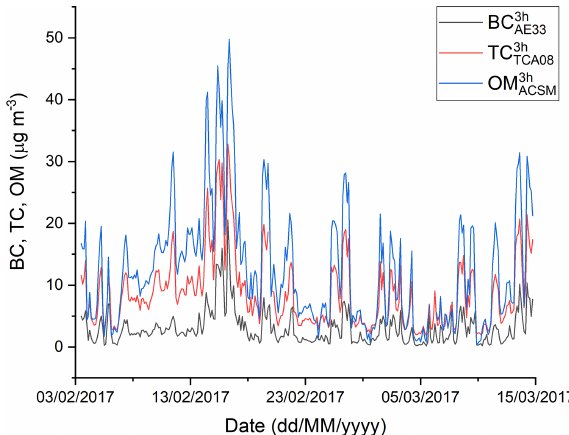
Figure 10. Time series comparisons of high-time-resolution online measurements of OM by ACSM on 29–30min time base, BC by AE33 on 1min time base and TC by TCA08 on 1h time base. All data are averaged to 3h for easier comparison.